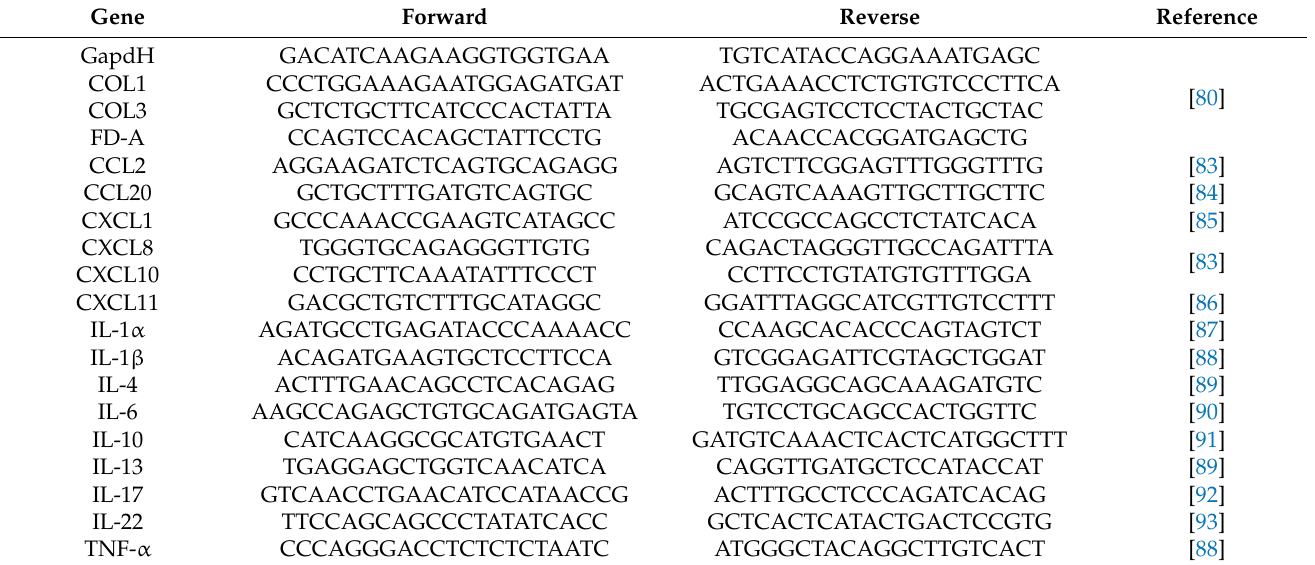
Table 1. Gene-specific primer sequences used in our